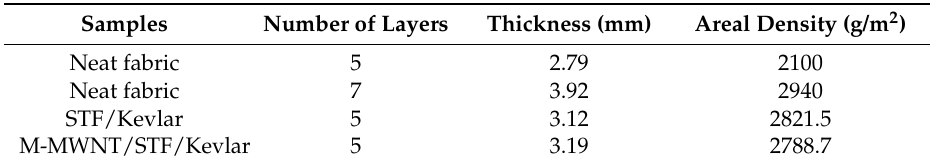
The parameters of stab test samples of neat fabrics, STF/Kevlar fabrics and M-MWNT/STF/Kevlar fabrics.